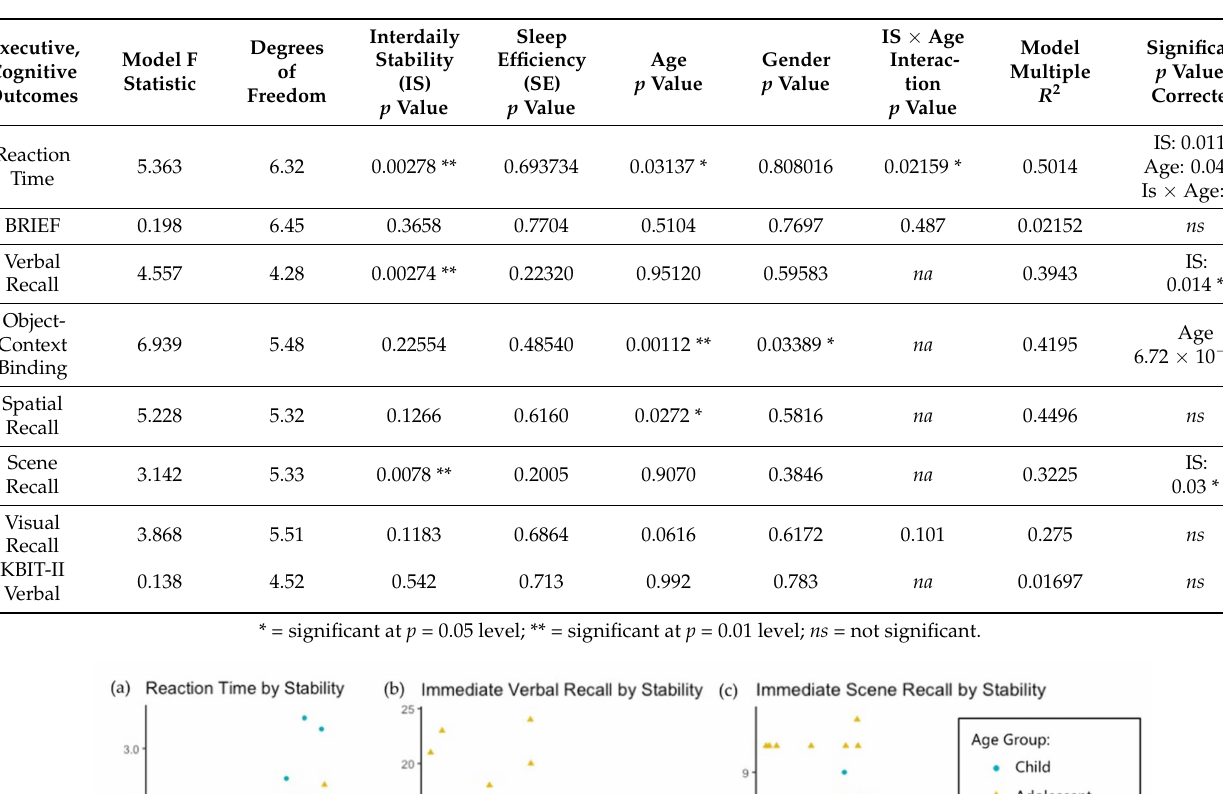
Table 4. Linear Model results for executive function, memory, and KBIT-II verbal intelligence models for individuals with DS.